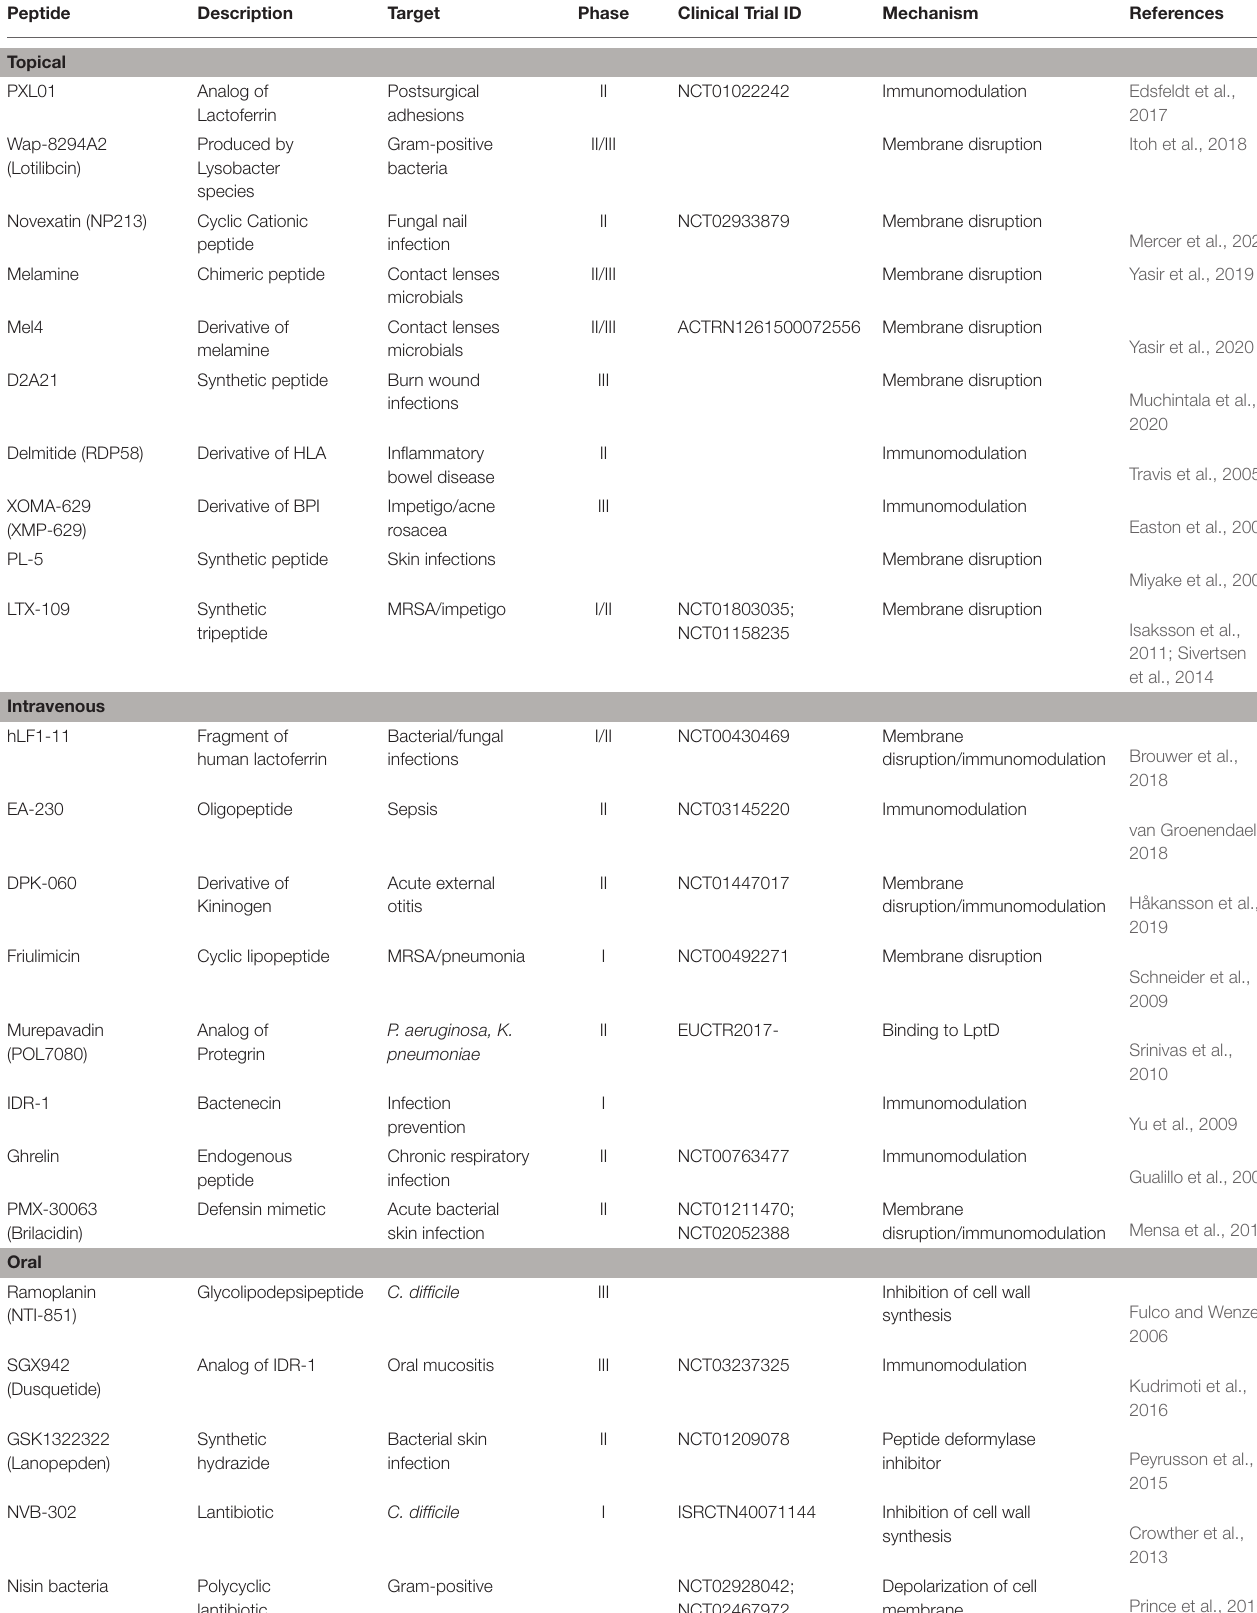
TABLE 2 | AMPs recently tested and approved by